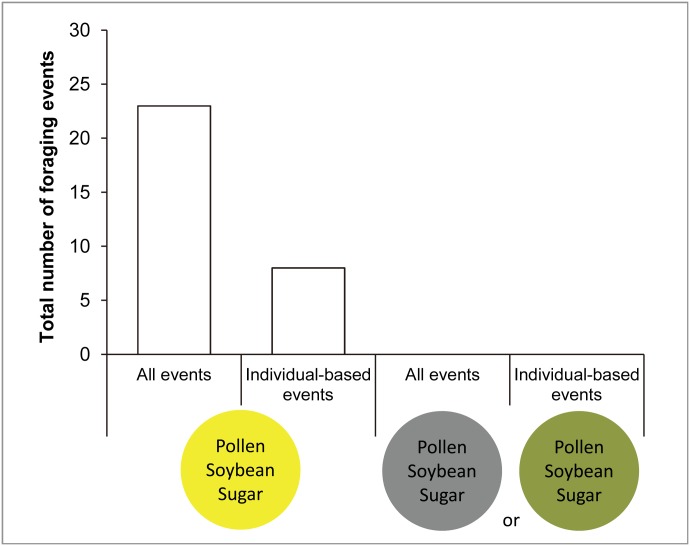
Number of foraging events in experiment 2 where the treatment is color (yellow versus black or green) in doughs containing pollen (Table 1).Open and solid bars as in Fig 2.